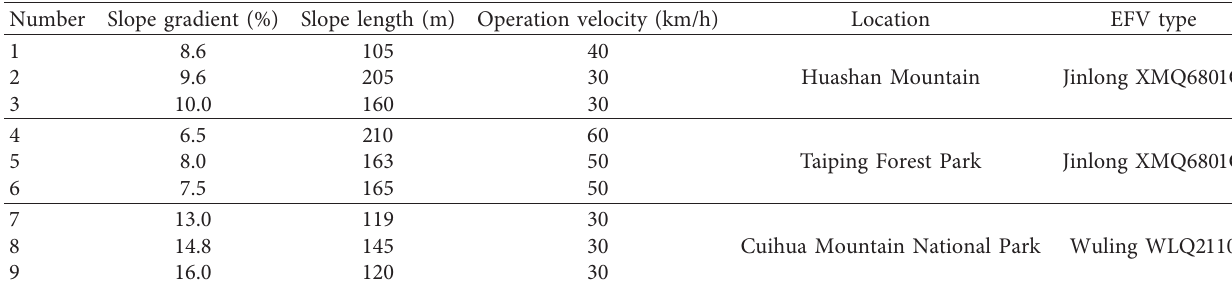
Table 4: The detailed information of chosen